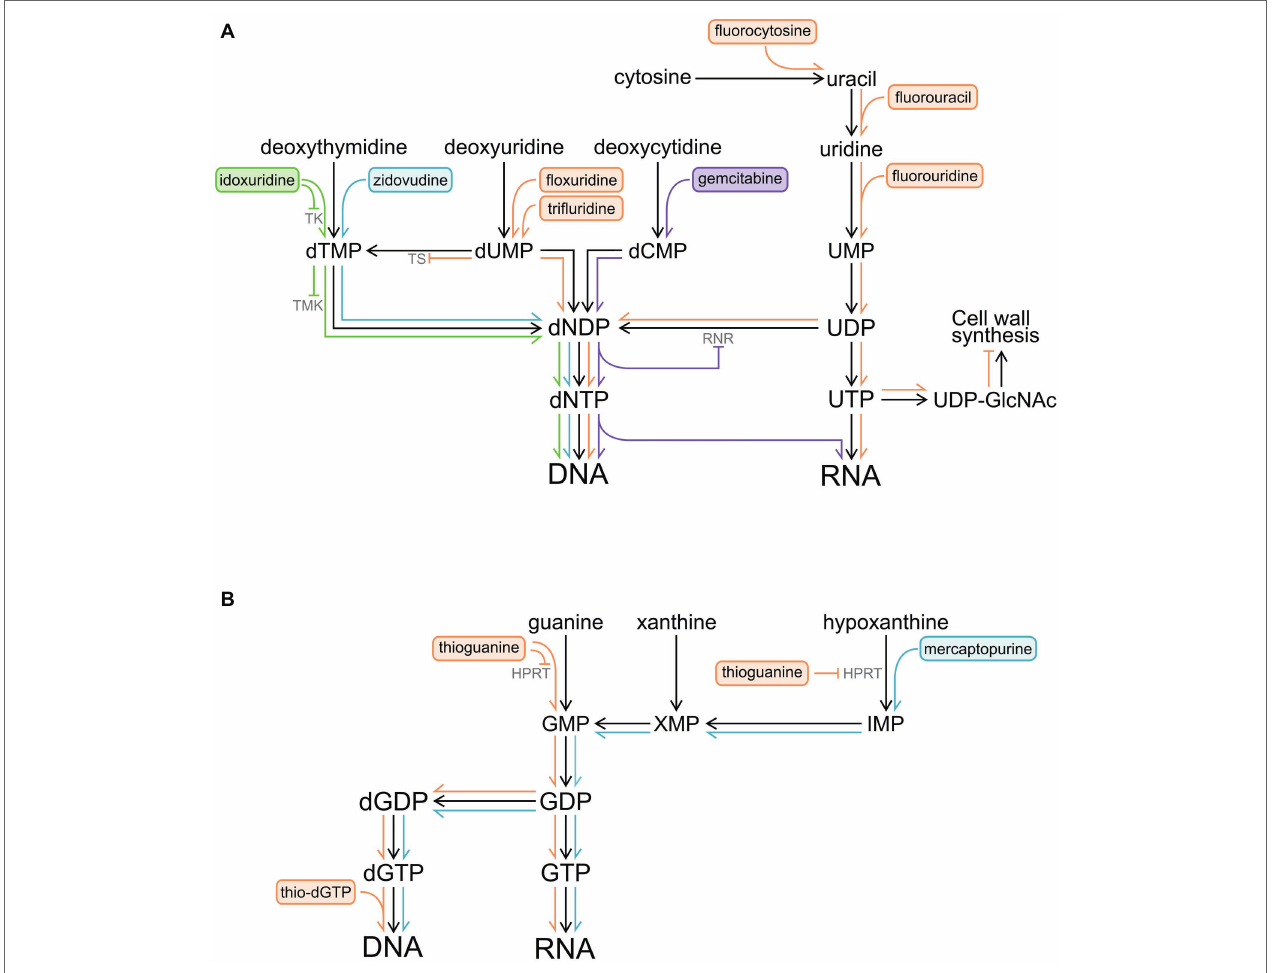
FIGURE 1 | Pathways by which pyrimidine and purine analogues are metabolized and become incorporated into DNA and RNA. Inhibition of enzymes by nucleoside analogues and their metabolites is also shown ( ⊣ ). (A) Pyrimidine analogues. (B) Purine analogues. Abbreviations: HPRT, hypoxanthine-guanine phosphoribosyl transferase; IMP, inosine monophosphate; RNR, ribonucleotide reductase; TK, thymidylate kinase; TMK, deoxythymidine monophosphate kinase; TS, thymidylate synthase; UDP-GlcNAc, uridine diphosphate N-acetylglucosamine; XMP, xanthosine